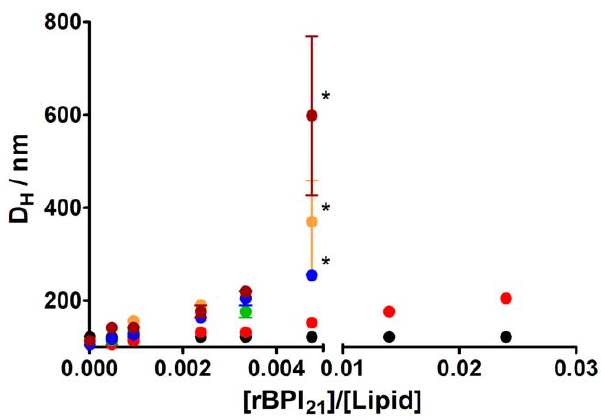
Figure 4. Aggregation of LUV caused by rBPI 21 . Hydrodynamic diameter variation of lipid vesicles with increasing rBPI 21 concentration. Bars represents the size range from three independent experiments. Larger ranges are intrinsically associated to vesicles flocculation/ precipitation (marked *). POPC (black circles); POPG (blue circles); POPC:POPG 55:45 (orange circles); POPC:POPG 80:20 (green circles); POPC:LPS 80:20 (red circles); POPC:POPG:LPS 60:20:20 (brown circles). The lipid concentration was kept constant at 50 m M. The differences in hydrodynamic size for [rBPI 21 ]/[Lipid]=0.0048 were statistically signif- icant for the following data pairs: POPC/POPC:POPG (80:20), POPC/ POPC:POPG (55:45), POPC/POPG, POPC/POPC:POPG:LPS (60:20:20), POPC:LPS (80:20)/POPC:POPG (80:20), POPC:LPS (80:20)/POPC:POPG (55:45), POPC:LPS (80:20)/POPG and POPC:LPS (80:20)/POPC:POPG:LPS